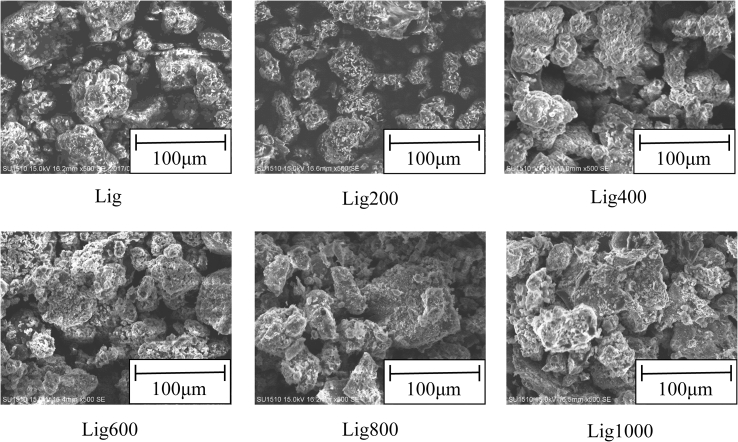
SEM images of adsorbents.